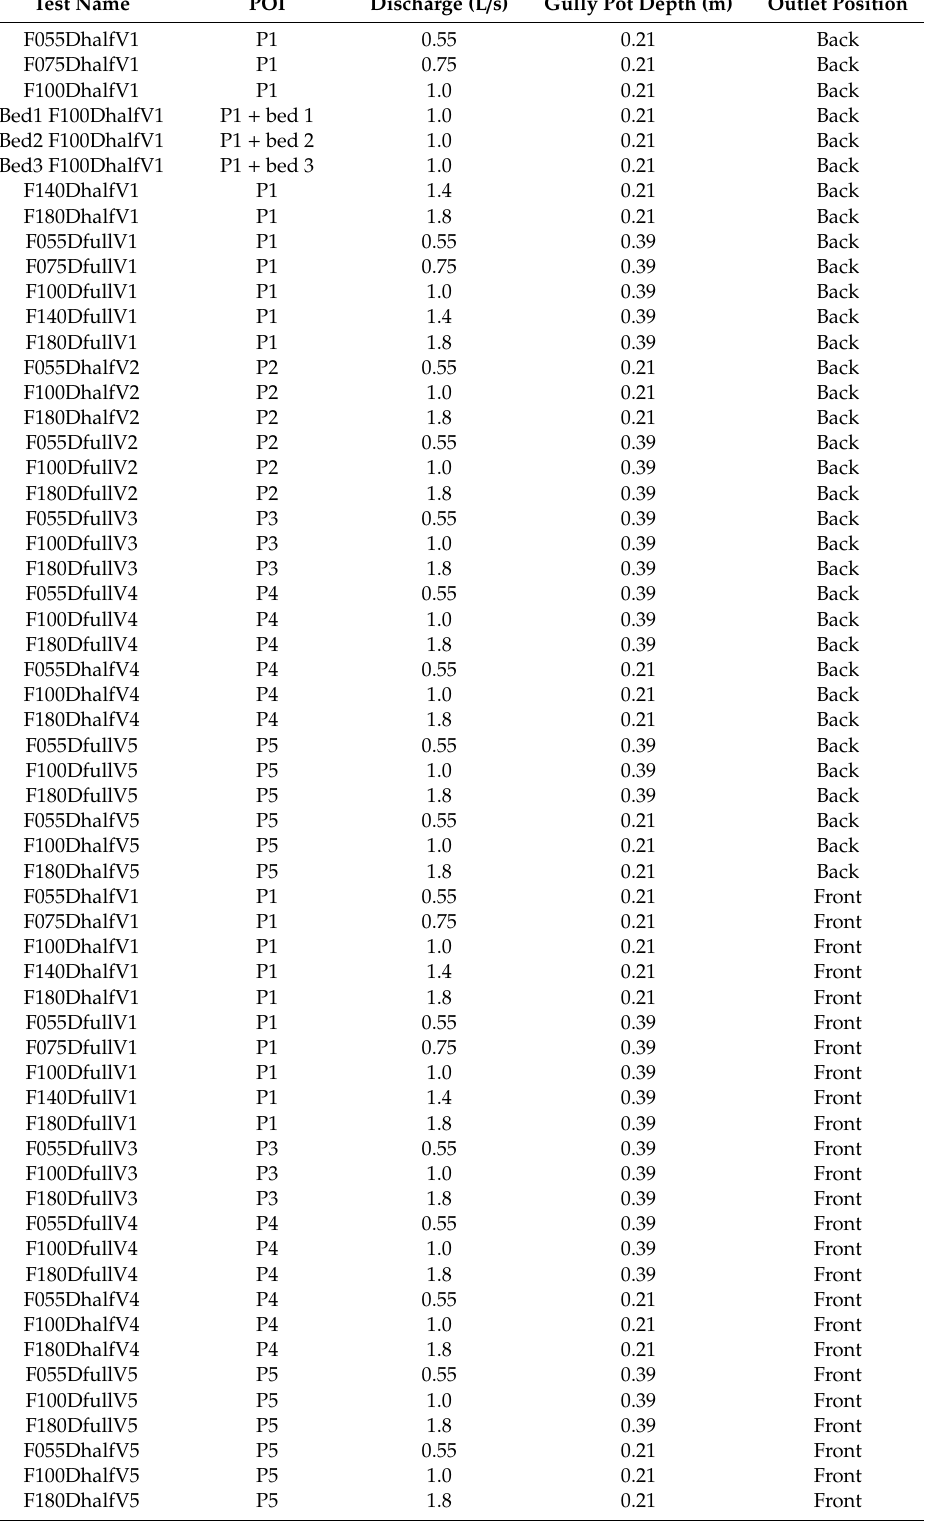
Table A1. Overview of the performed PIV